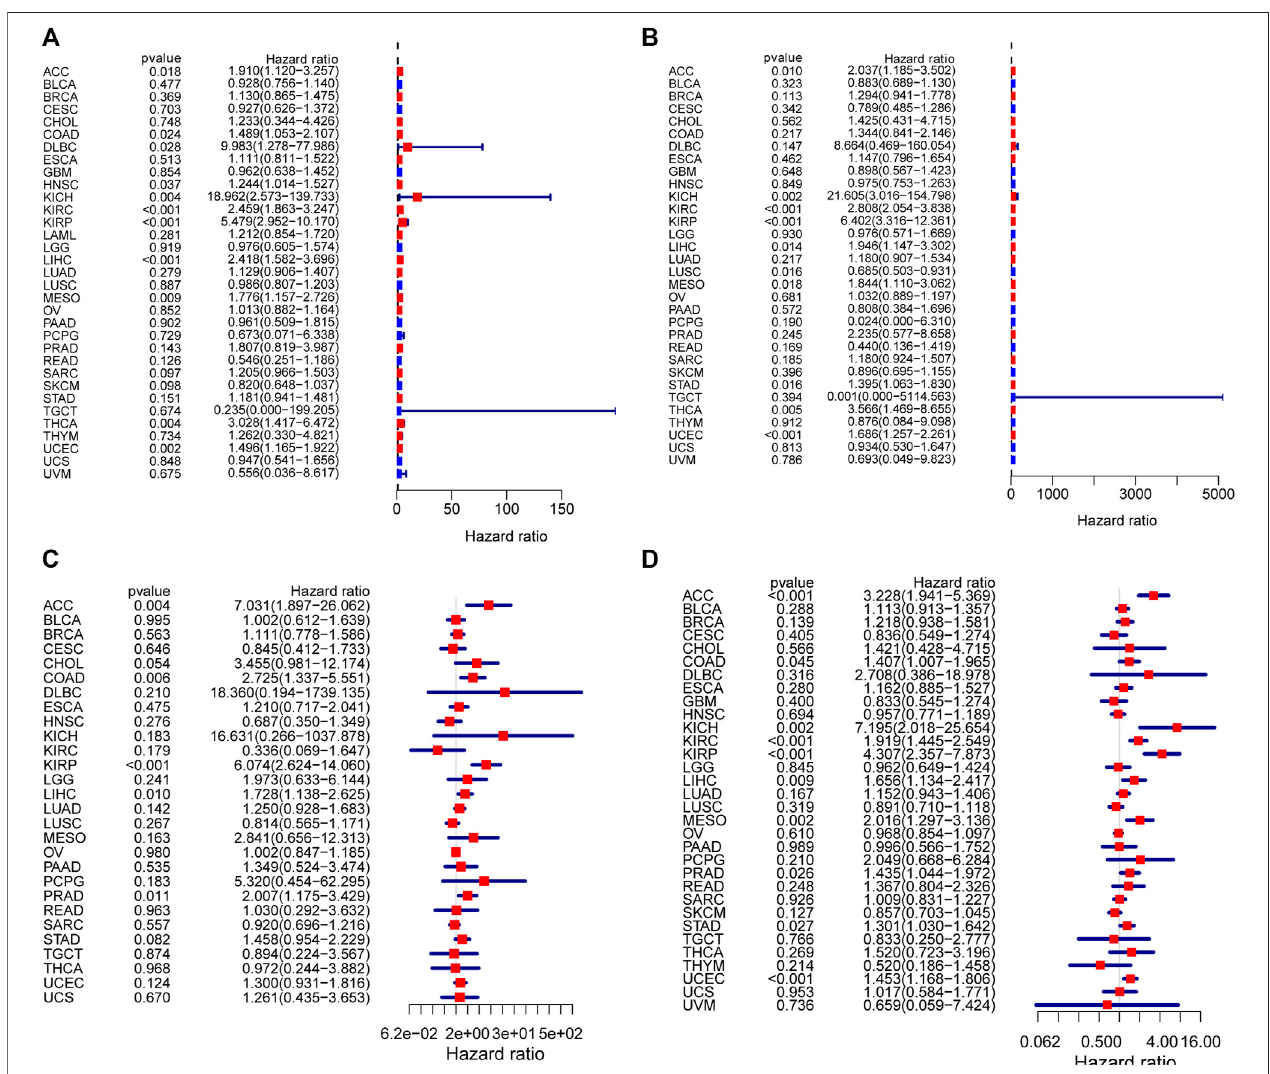
FIGURE 3 | Correlation analysis of DUXAP8 expression with survival using the COX method for different types of cancers in TCGA. (A) : OS. (B) : DSS. (C) : DFI. (D) : PFI.